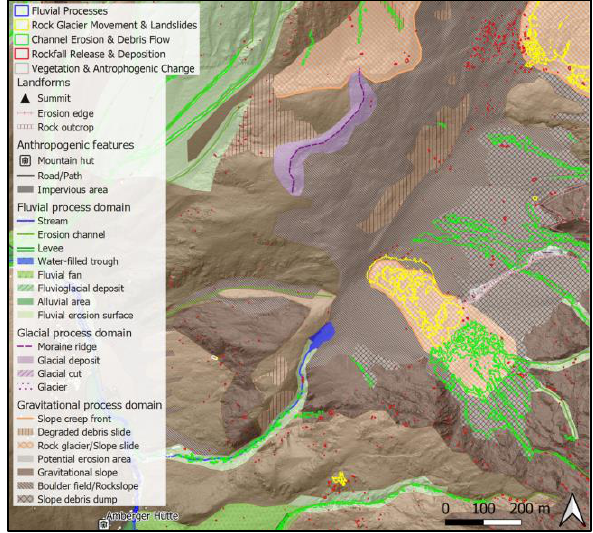
Figure 10 . Map subset comparing the semi-automatic change detection and classification with manually mapped geomorphological landforms.